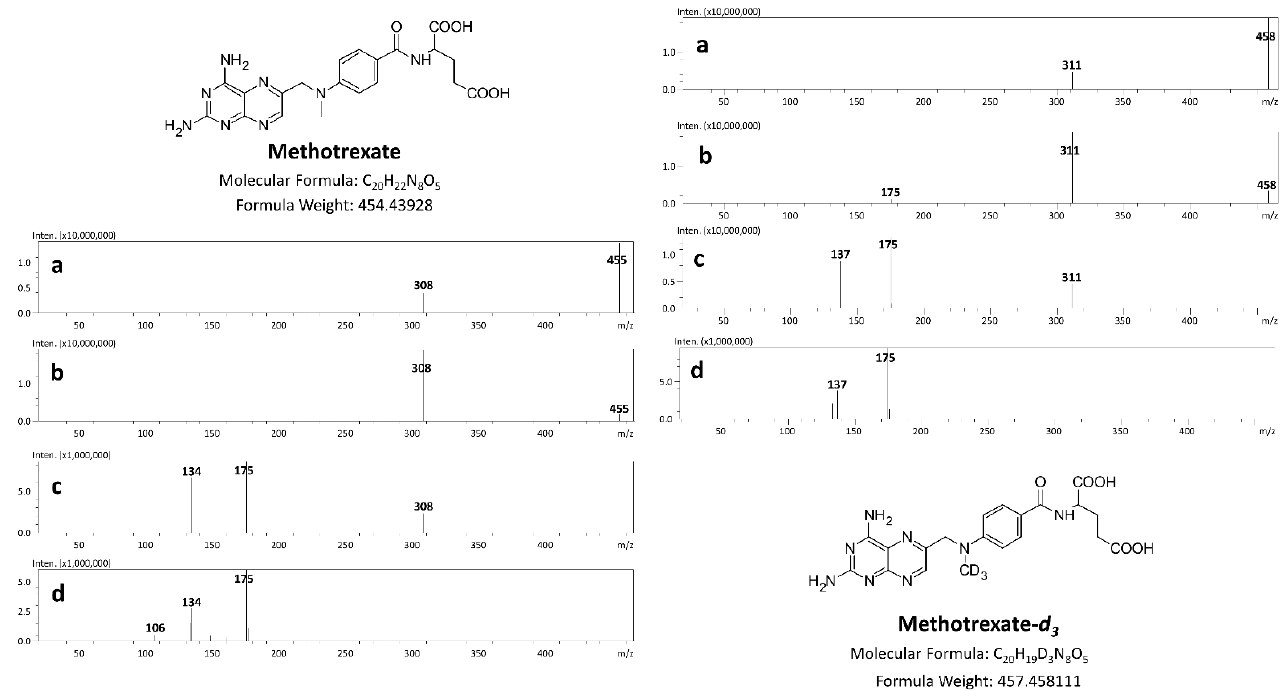
Figure 3. Product ion scan spectra of methotrexate and methotrexate- d 3 at different collision energies: ( a ) 10 V; ( b ) 20 V; ( c ) 35 V and ( d ) 50 V. The linear concentration range was from 0.1 to 1000 ng/mL or ng/g for methotrexate in the blood and kidney. The coefficient of determination values ( R 2 ) were >0.996 for all